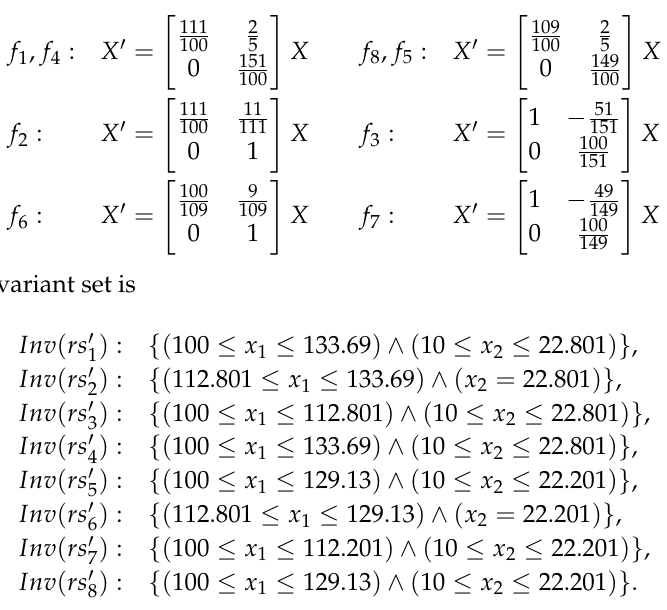
Figure 8. ILAHS of feed-water control